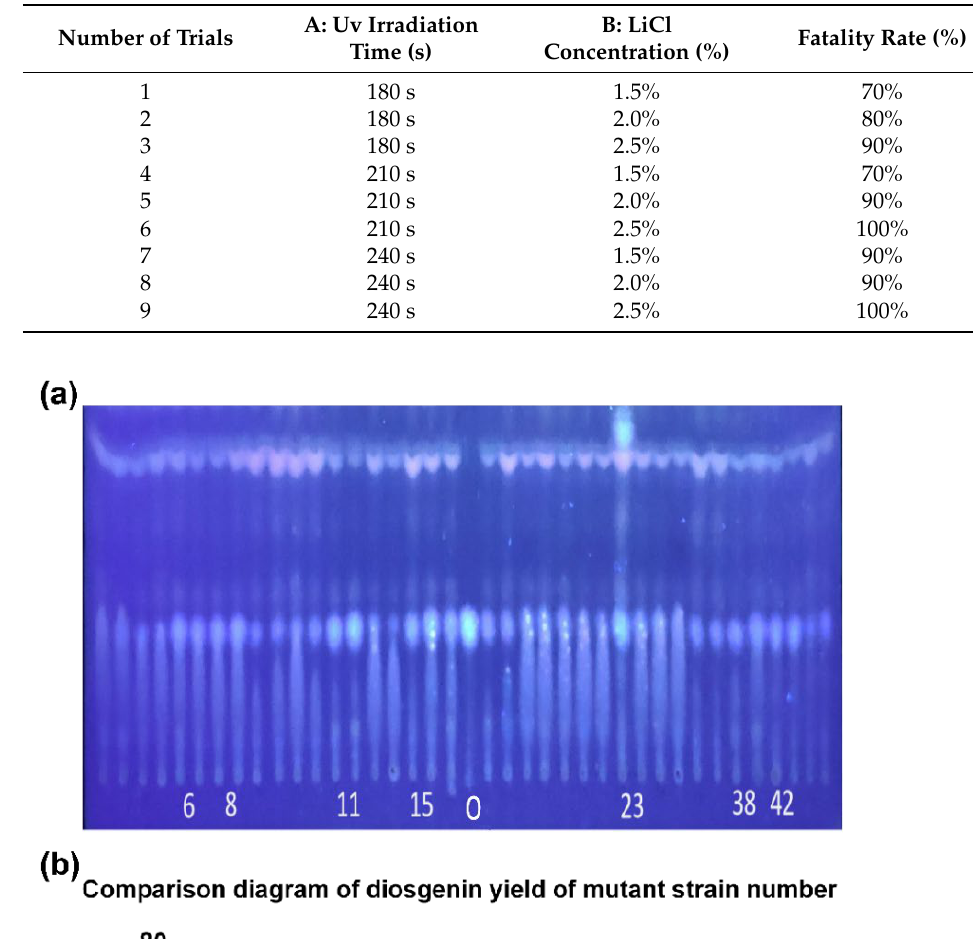
Table 3. The results of crossover experiments with compound mutagenesis conditions.